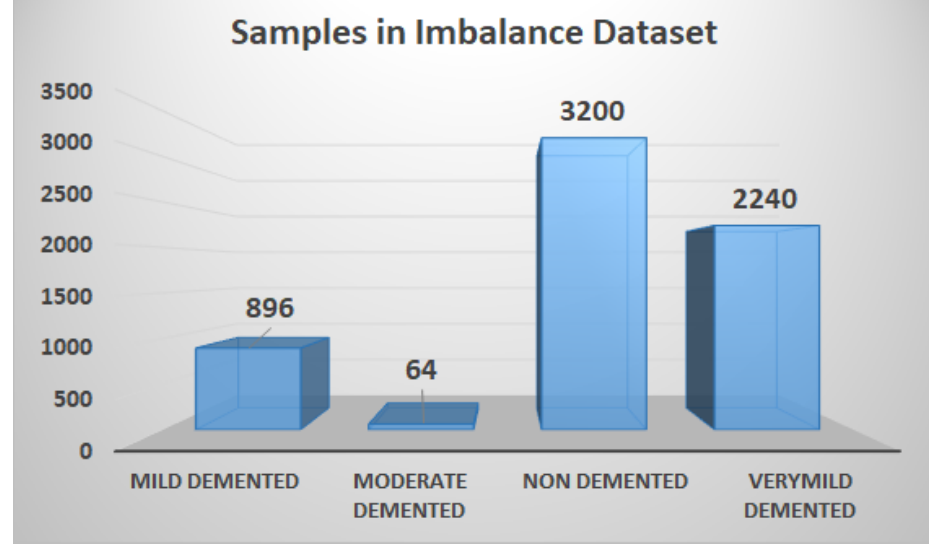
Figure 3. AD data-set class distribution before up-sampling through ADASYN.